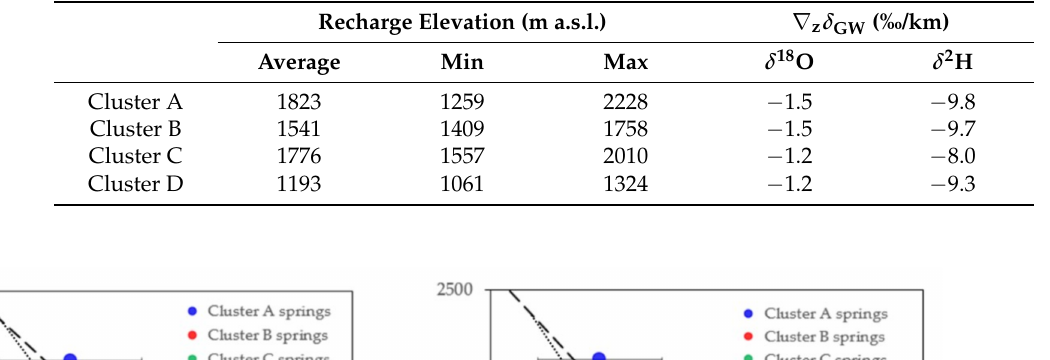
Table 1. Recharge elevation associated with GW clusters in the PCM.